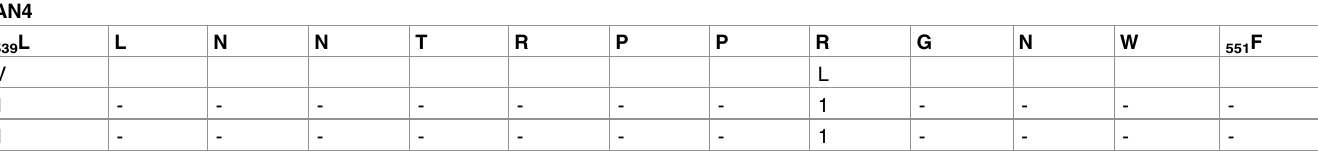
Data presented is analysed and predicted using programme SIFT (http://sift.jcvi.org/www/SIFT_aligned_seqs_submit.html). Row corresponds to a position in the reference epitope. Column corresponds to amino acid variation (observed in our data set) at that position in different HCVpp (Fig 4A). Score at a particular position for an amino acid substitution is mentioned below the amino acid variant. The default threshold for functional intolerance used was 0.05 for amino acid